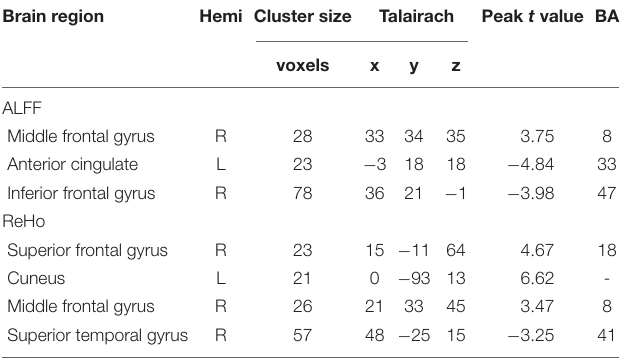
TABLE 6 | ALFF and ReHo changes in patients with MMoA after TA.